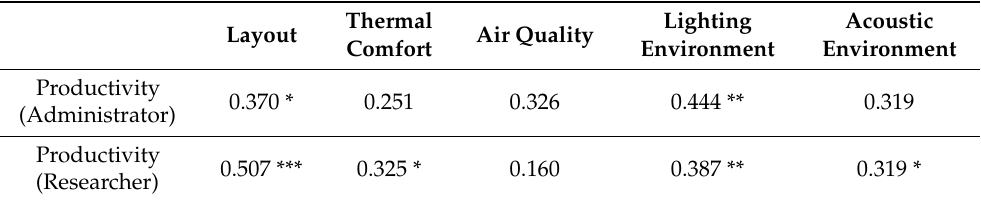
Table 9. Spearman rank correlation coefficients of work productivity and IEQ